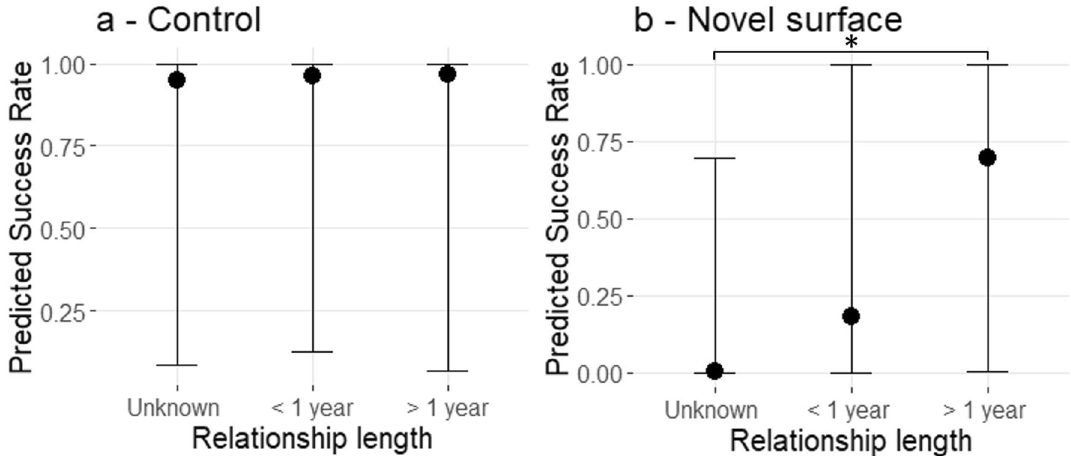
Figure 2. Predicted success rate depending on mahout-elephant relationship length. ( a —control, b —Novel surface) Bars represent the 95% credibility intervals. (Bayesian regression models from Table 2). “*” means significant differences in between the variables from the extremity of the